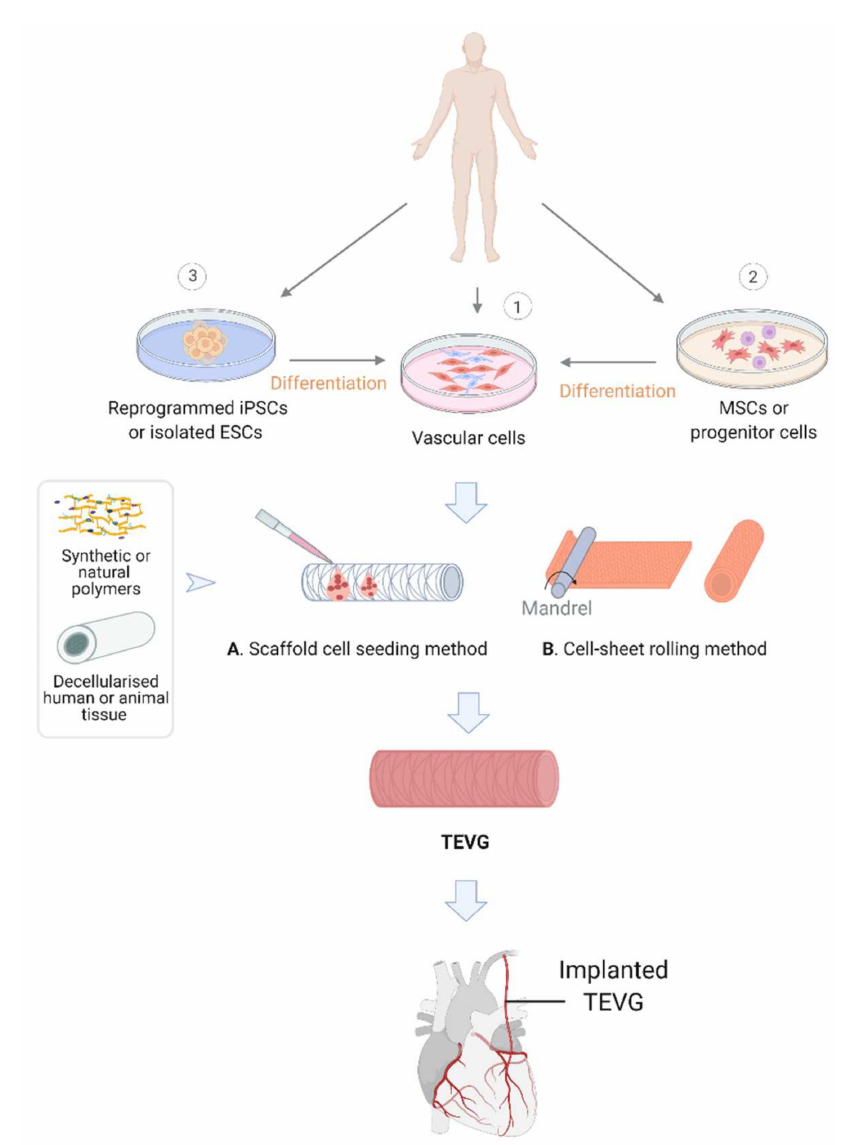
Figure 2. Vascular tissue engineering. Vascular cells can either be harvested from donors (1) or differentiated from mesenchymal stem cells (MSCs) or progenitor cells isolated from donors (2). Vascular cells can also be differentiated from pluripotent cells such as isolated embryonic stem cells (ESCs) or induced pluripotent stem cells (iPSCs) that were reprogrammed from somatic cells (e.g., dermal fibroblasts or blood monocytes) of the donor (3). A-Scaffold-based tissue-engineering: Vascular SMCs and ECs are seeded onto scaffold materials that can either be synthetic polymers or decellularised vascular scaffolds. B-Scaffold-free vascular engineering: TEVG produced via vascular cell bioprinting or rolling sheets of autologous vascular cells into a tubular structure. The constructs from A or B are then cultured ideally in a bioreactor to develop suitable properties of a TEVG for clinical implantation such as coronary artery bypass grafting. (Created with Biorender.com, accessed on 8 January